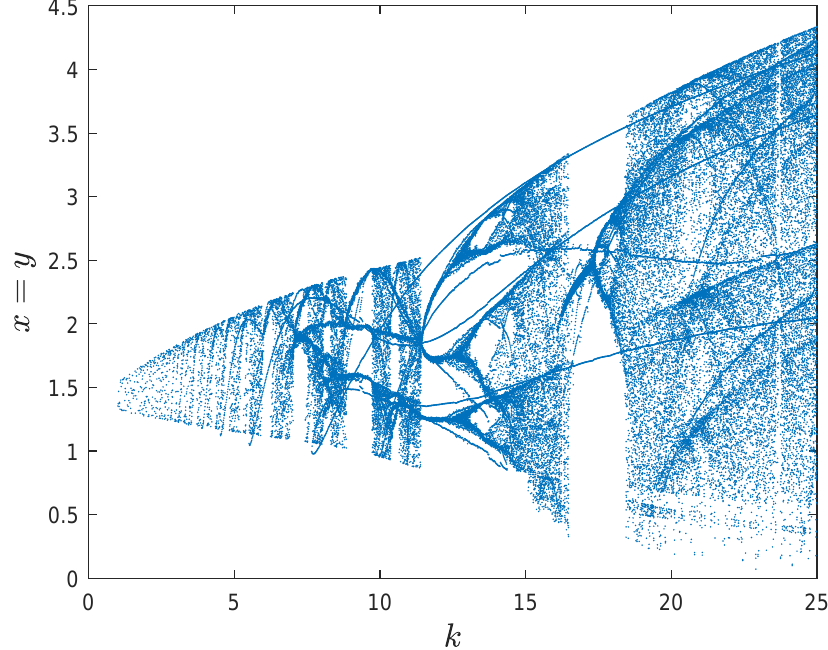
Figure 7. Bifurcation diagrams with respect to parameter k of Poincare cross-section when x = y